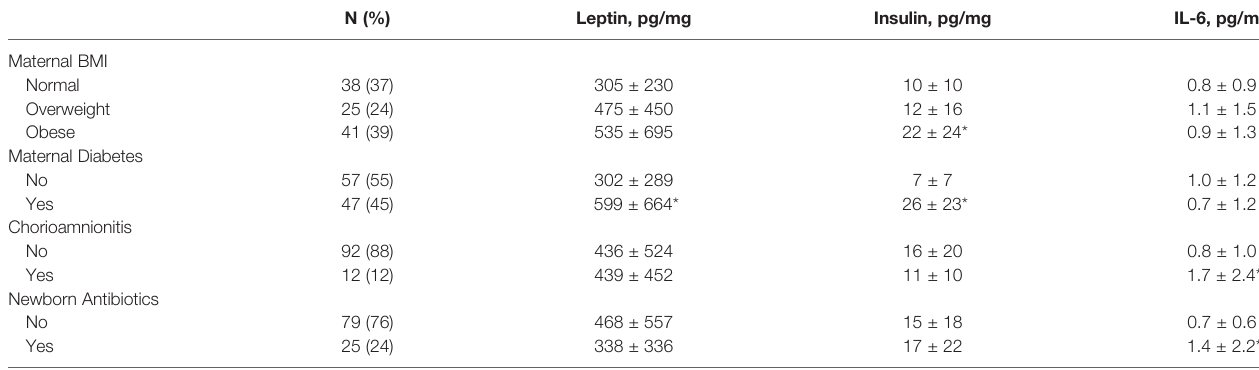
TABLE 2 | Perinatal risk factors and their association with cord blood protein levels, reported as pg/mg total protein. N (%) Leptin,